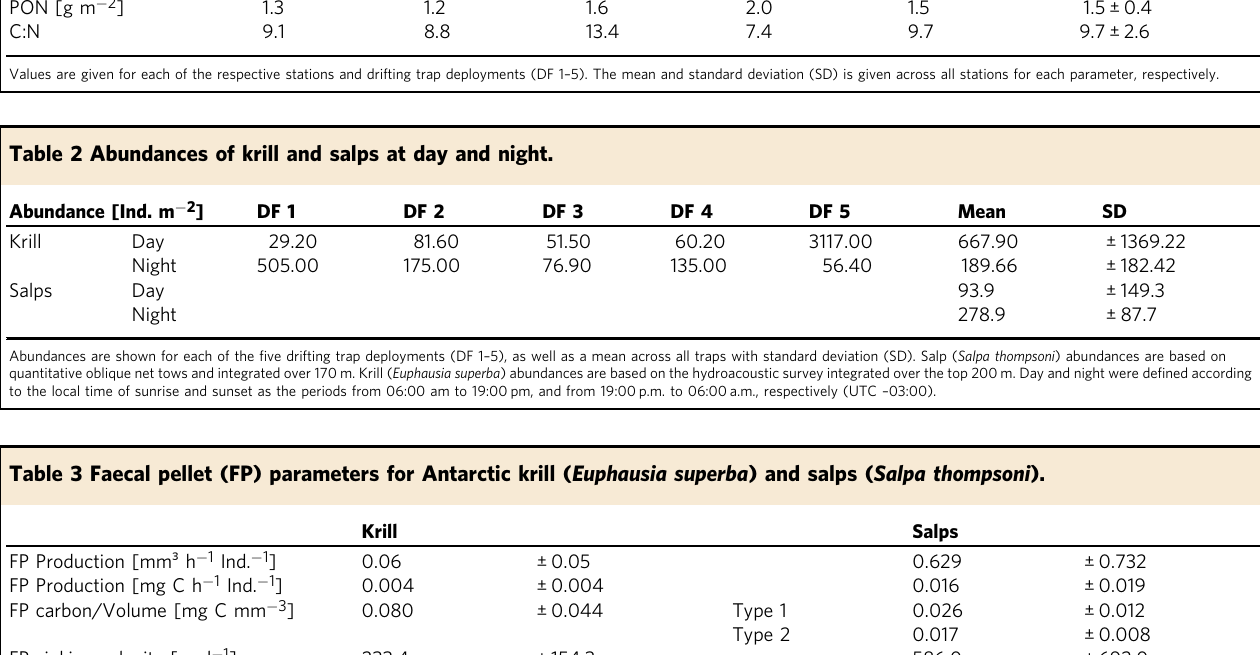
Salp abundances are based on quantitative oblique net tows and integrated over 170m. Krill abundances are based on the hydroacoustics survey integrated over the top 200m. For FP, the volume and carbon − speci fi c production rates and sinking velocities are given for krill and salps, respectively. FP carbon content is shown for krill FP and the two types of salp FP (type 1 = phytoplankton, type 2 = ingested krill FP). Values are given as mean across all sediment trap deployments. The SD is shown for each